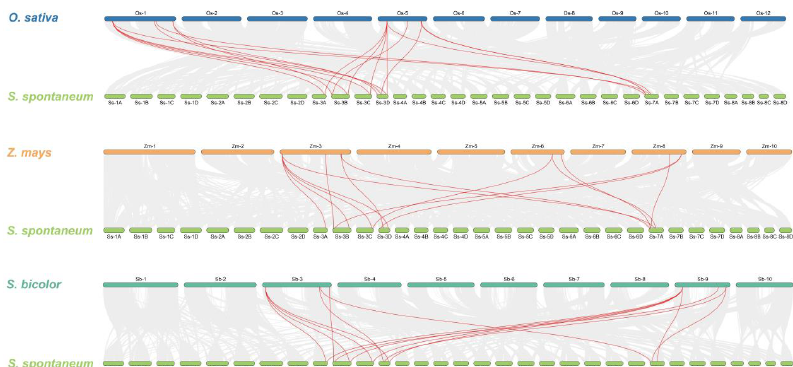
Figure 4. Synteny analysis of HXK genes between S. spontaneum and O. sativa , S. spontaneum and Z. mays , S. spontaneum and S. bicolor , respectively. Gray lines in the background indicate the collinear blocks, while the red lines highlight the syntenic HXK gene pairs. The chromosome number is shown at the top or bottom of each chromosome.